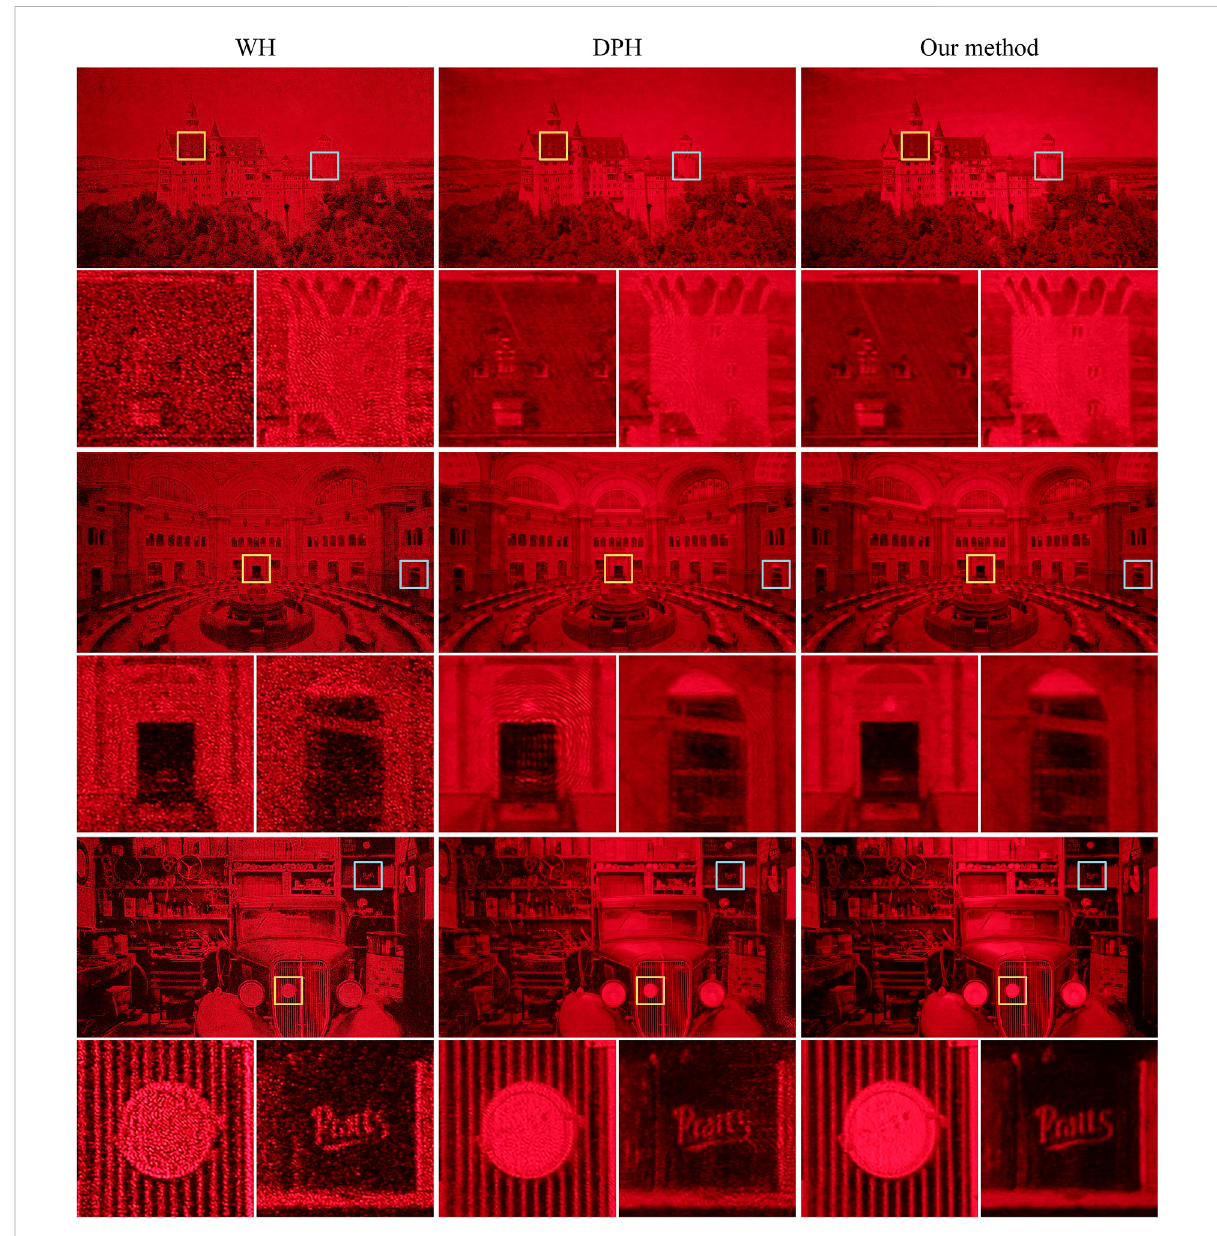
FIGURE 14 Optical reconstructed images of phase-only holograms generated by different methods. The physical size of the reconstruction is 8.08 mm × 14.36 mm.